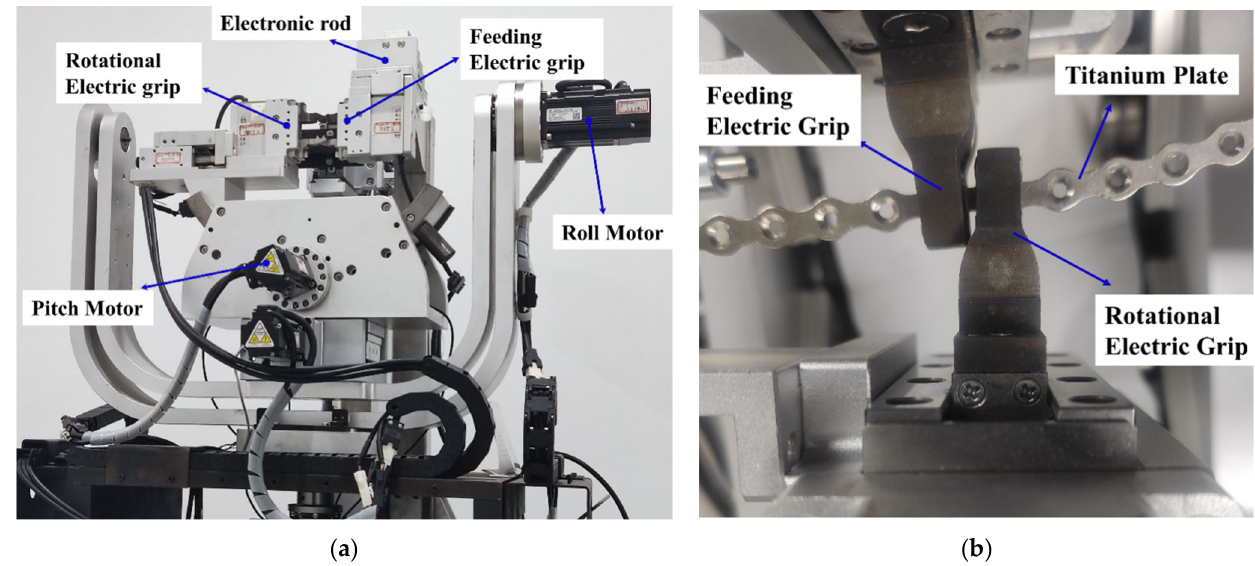
Figure 6. ( a ) Overall experimental device of the forming robot. ( b ) Zooming in on the top of the forming robot.